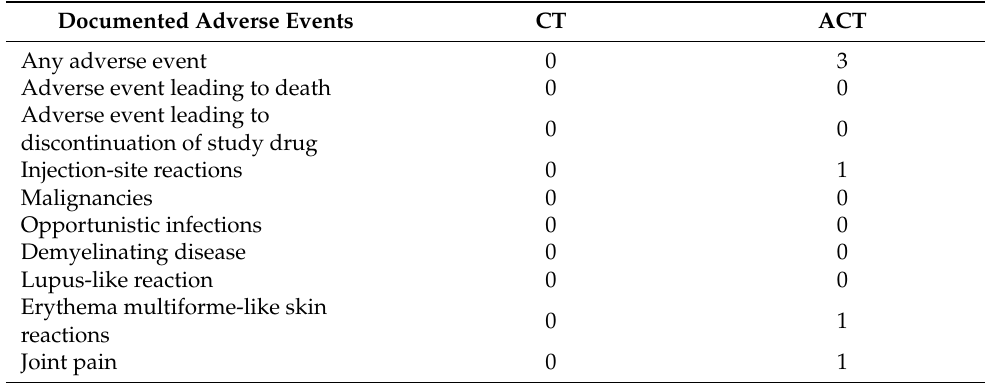
Table 3. The adverse events in the 2